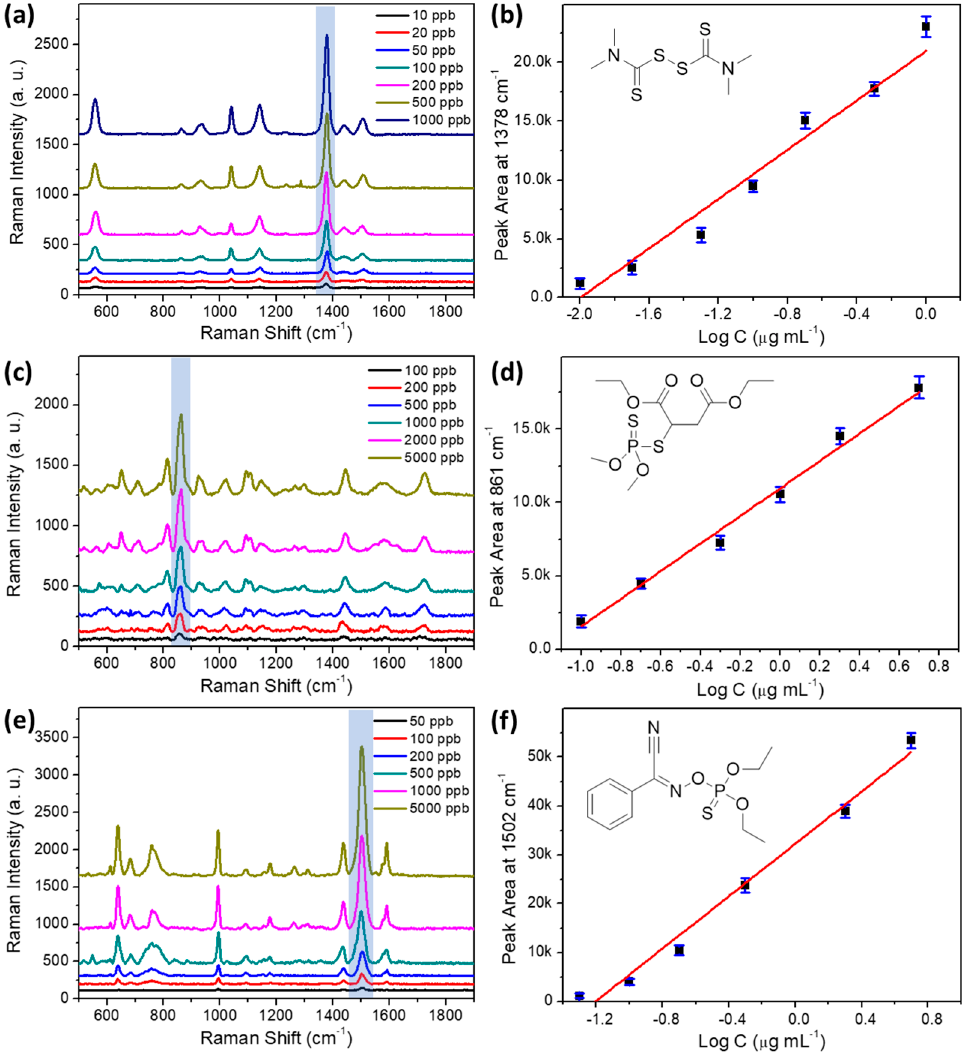
Figure 4. SERS spectra of different concentrations of thiram ( a ), malathion ( c ), and phoxim ( e ). Linear calibration plots between the integrated peak area and the logarithm of concentration for thiram ( b ), malathion ( d ), and phoxim ( f ). Inset of ( b , d , f ): molecular structure of thiram, malathion, and phoxim. Table 1. Assignments of some characteristic bands in Raman and SERS spectra of three tested pes- ticides.